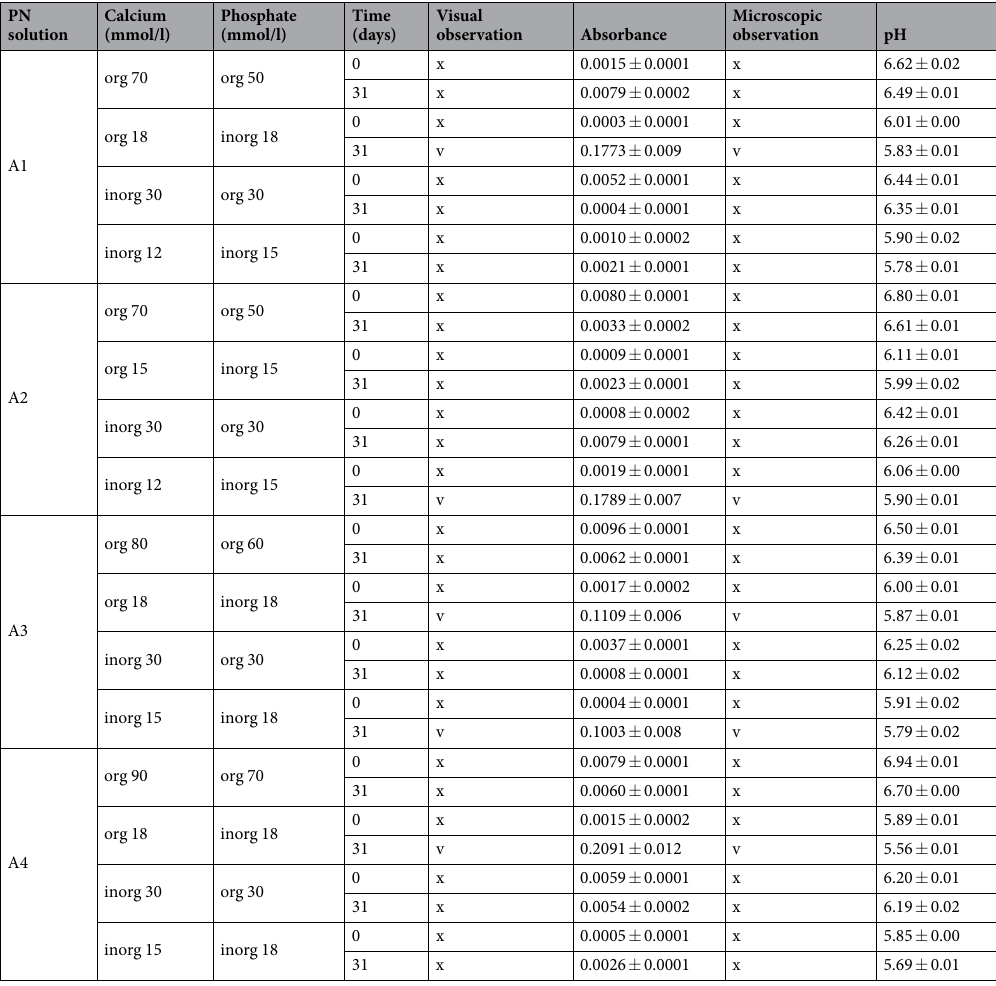
Table 2. Physicochemical Properties of PN Solution Composition A (n = 9; mean ± SD). x = no precipitation. v =